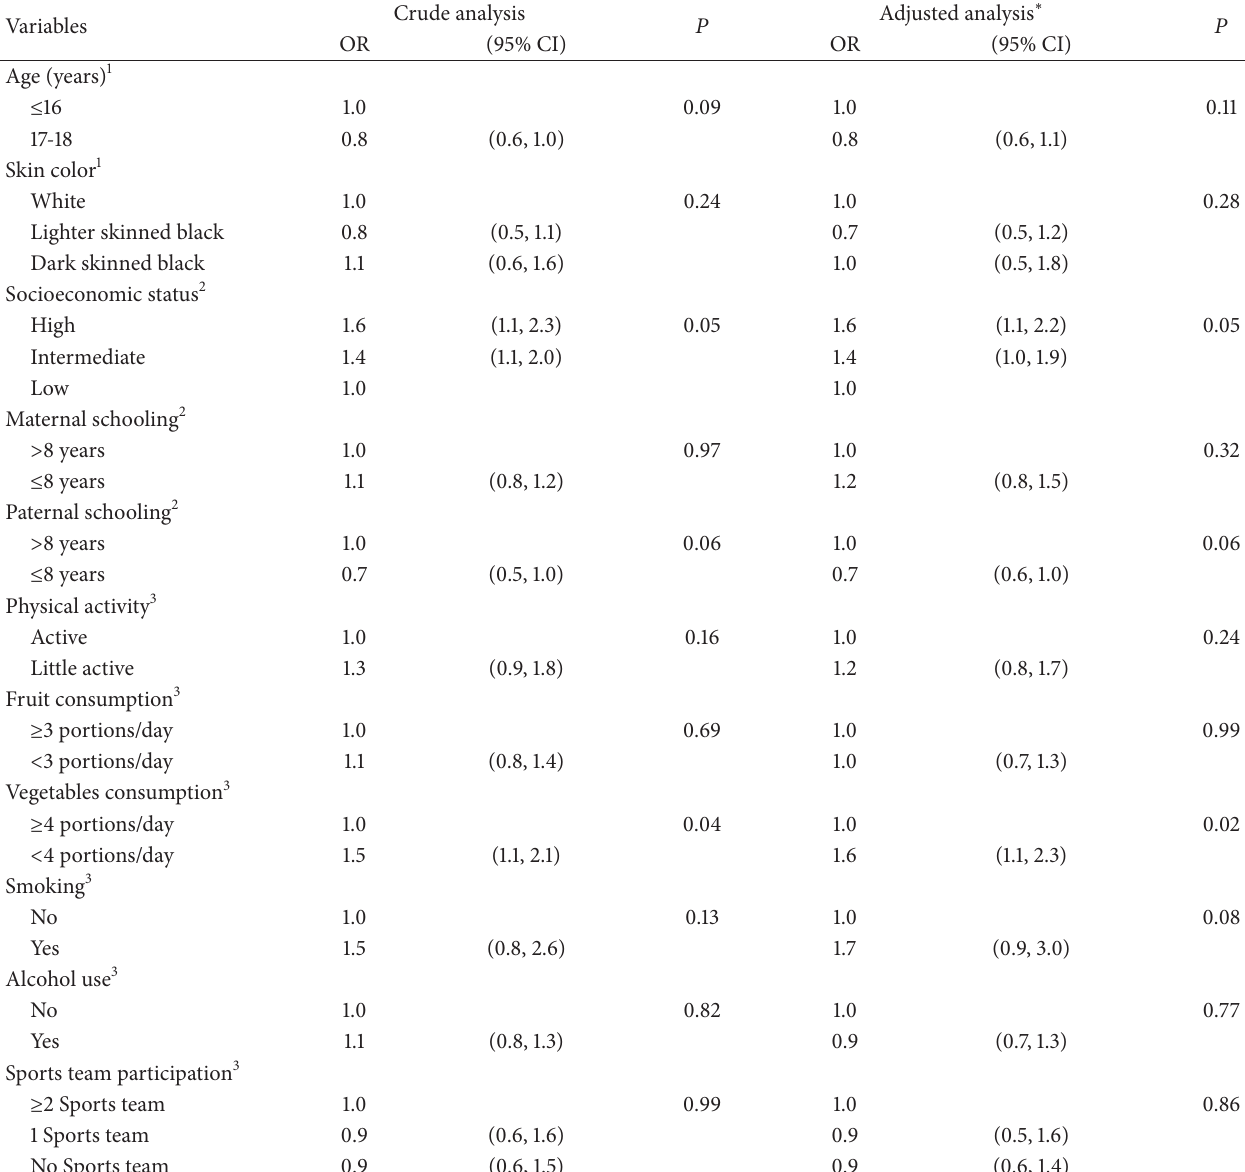
Table 3: Estimated odds ratios and 95% confidence intervals in the association between excess television time and independent variables in